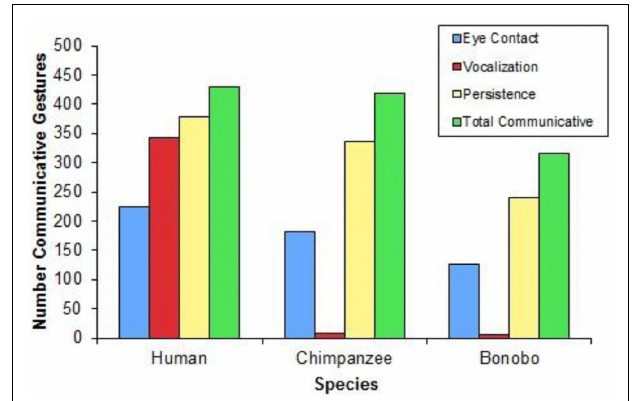
FIGURE 10 |A comparison of the use of eye contact, vocalization, or persistence when gesturing relative to total communicative gestures across